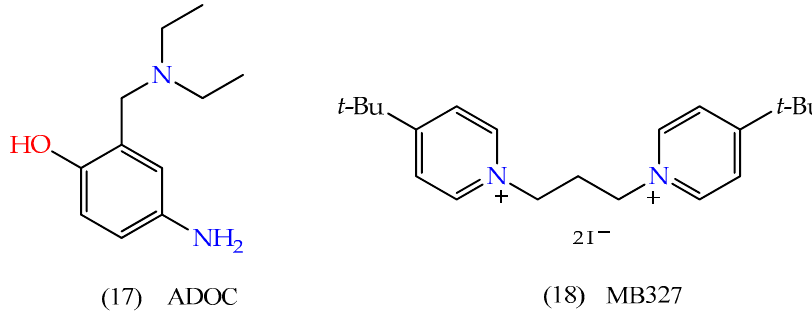
Figure 11. Chemical structures of 4-amino-2-(diethylaminomethyl)phenol (ADOC) and 1,1’-(propane-1,3-diyl)bis(4-tert-butylpyridinium)di(iodide) (MB327).